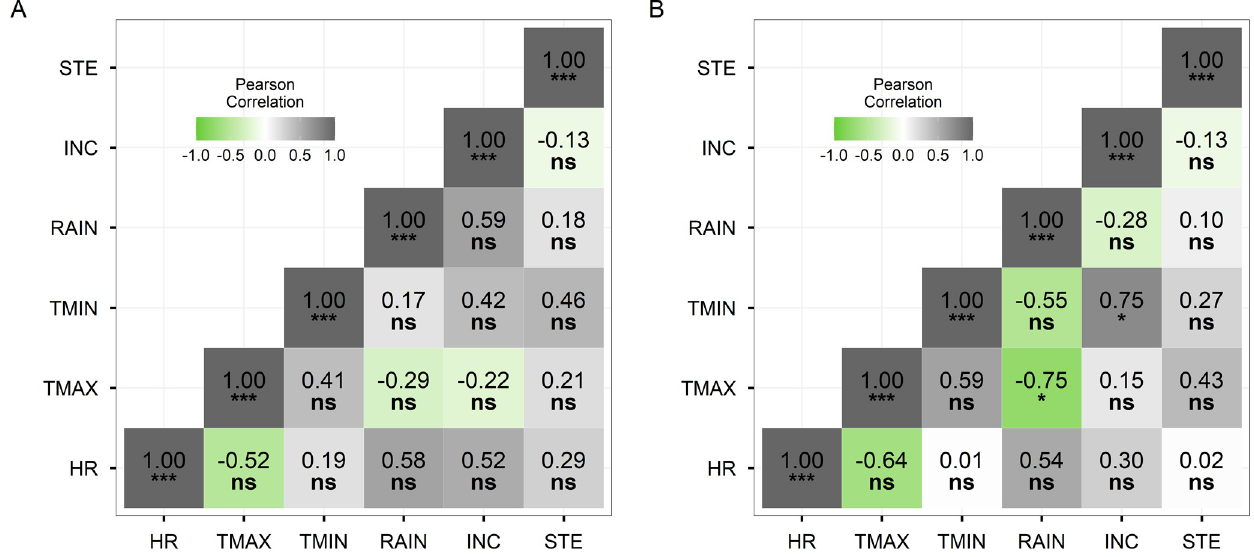
Fig 4. Pearson Correlation between Disease Variables and Climate Variables for 10 Days Before (A) and 10 Days After (B) Flowering Date. HR, relative humidity; TMAX, maximum temperature; TMIN, minimum temperature; RAIN, precipitation; INC, disease incidence; STE, spikelet sterility.